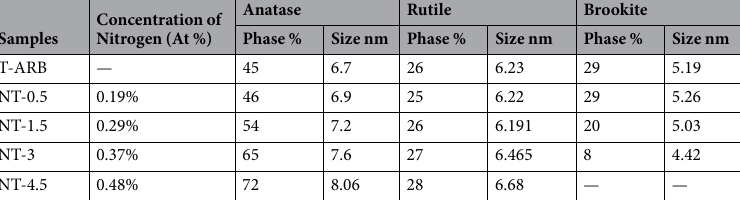
Table 1. Quantification and crystallite size of individual phases in TiO 2 and N-TiO 2